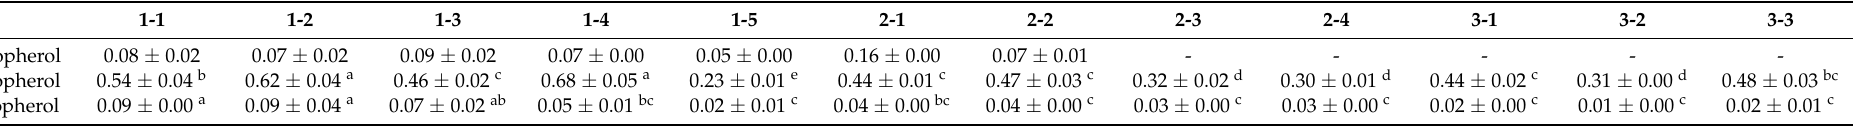
Table 11. Content of tocopherols in fresh corn in the three